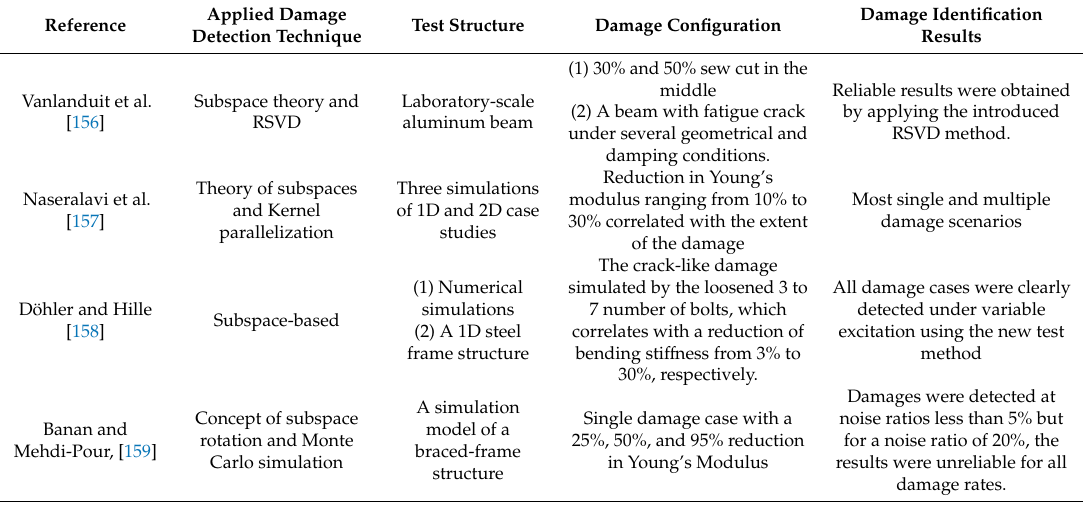
Table 7. Application of SSI algorithms for damage detection of beams and two-dimensional (2D)